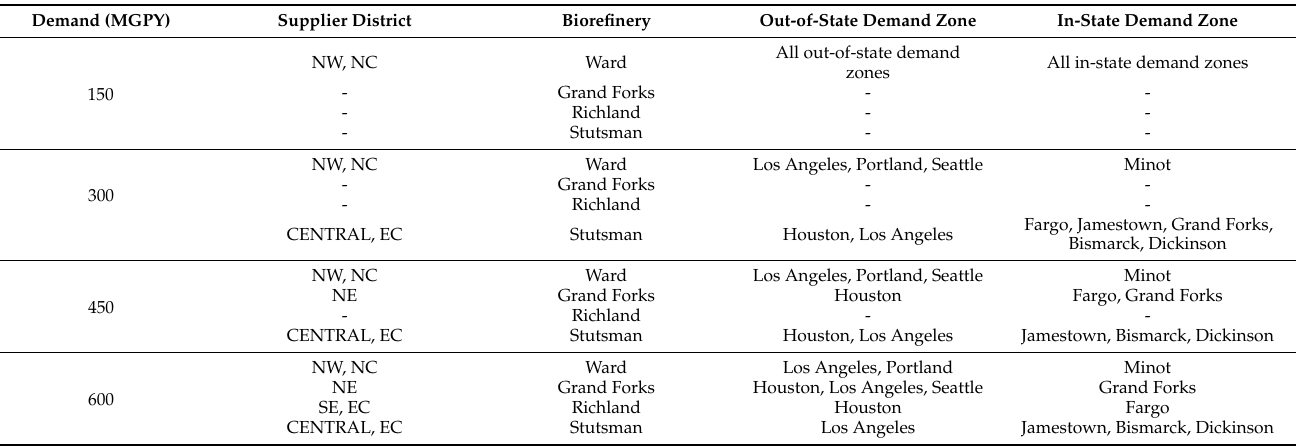
Table 3. Optimal assignment of supply zones and demand zones to bioethanol plants disregarding emissions and energy use